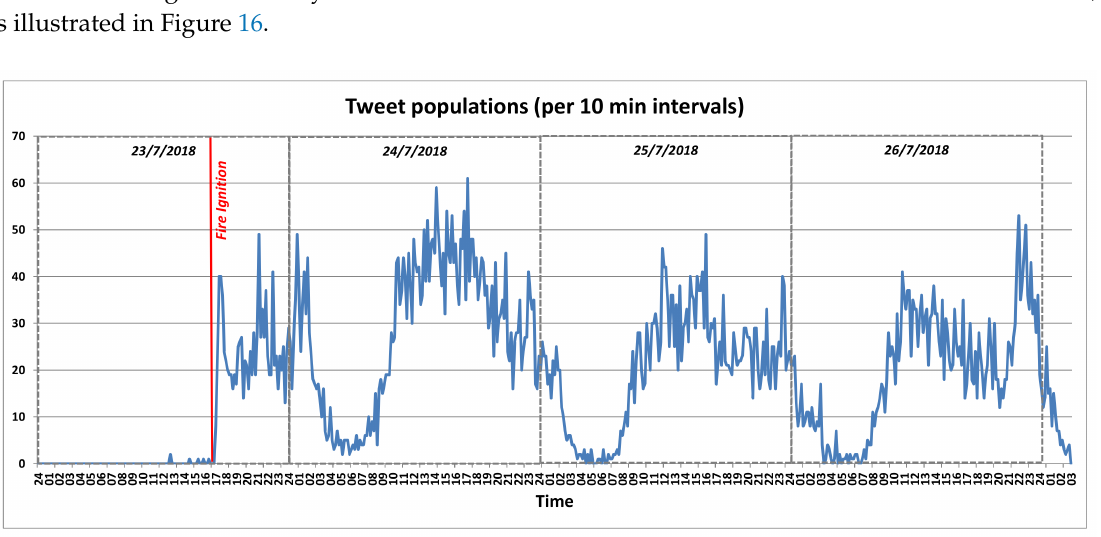
Figure 16. Tweet populations that are linked to the Mati-Rafina fire incident on 23/7/2018, aggregated over 10 min